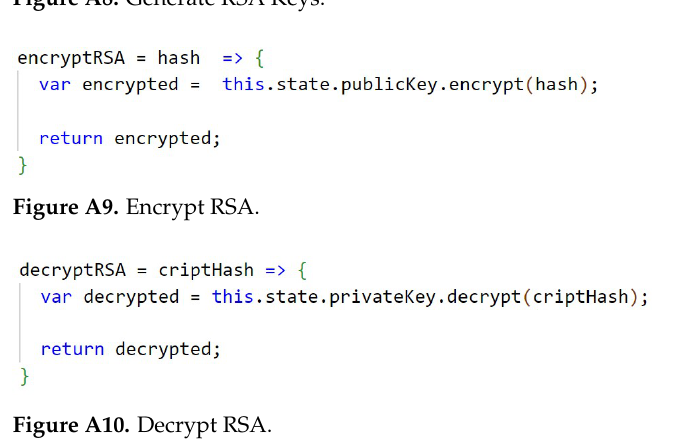
Figure A10. Decrypt